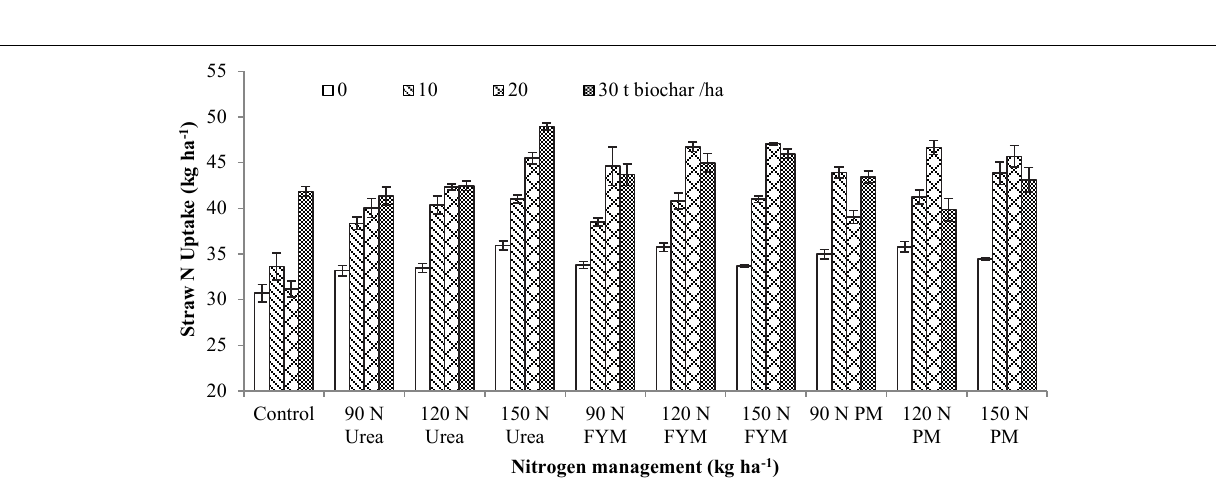
FIGURE 9 | Interactive effect biochar and N levels applied from different sources on straw nitrogen uptake of wheat. Bars on graph denote SE of mean ( n = 3). FYM, farmyard manure; PM, poultry manure.